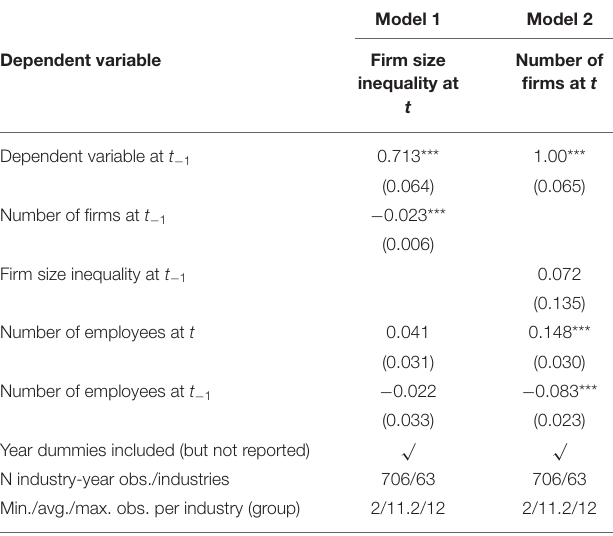
TABLE 2 | Dynamic unconditional quasi-maximum likelihood fixed effects panel model with robust standard